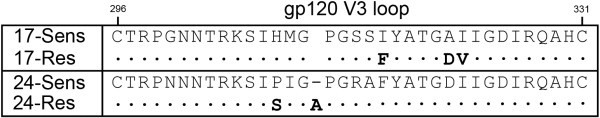
V3 loop amino acid alterations responsible for resistance to MVC by viruses harbored by subjects 17 and 24. The V3 loop alterations shown in bold face were demonstrated to be associated with resistance to MVC by 17-Res and 24-Res Envs [47,56]. Dots indicate residues identical to the parental sensitive Envs, and dashes indicate gaps. The numbering is based of the HXB2 Env amino acid sequence.